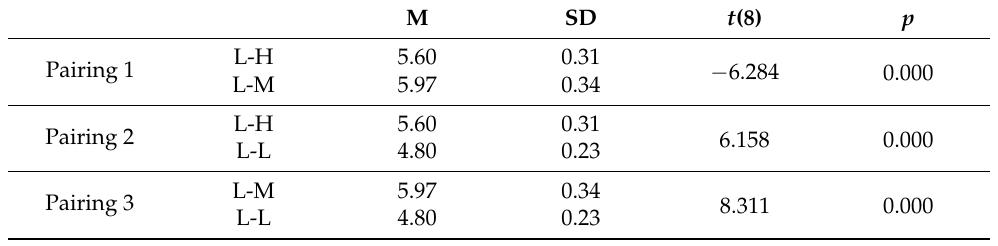
Table 3. Time distribution results table of low pitch–height.